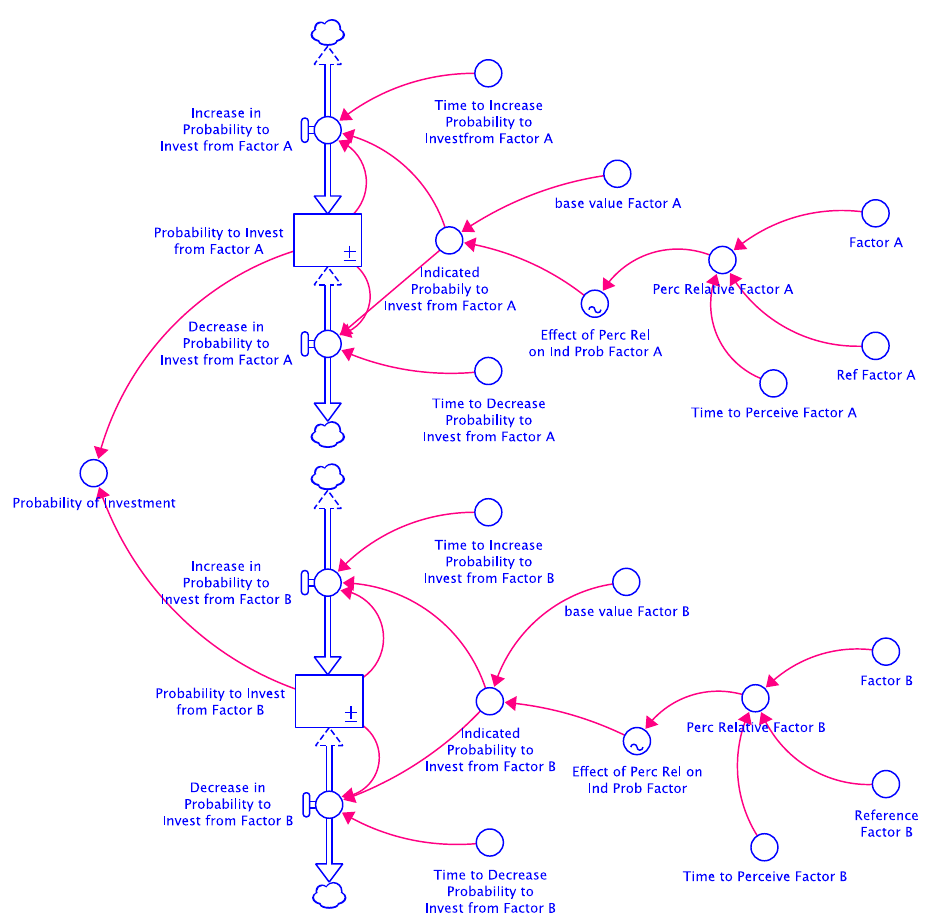
Figure 7. Generic stock and flow structure for decision making in multi-family building sector sub-module.